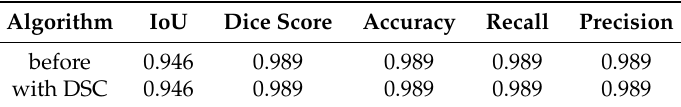
Table 5. Metrics measured before and after applying the Depthwise Separable Convolutions (DSC) on FC-DenseNet103